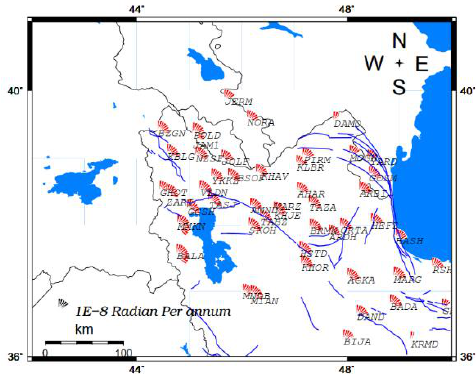
Figure 4. Map of the rotation rates in NW